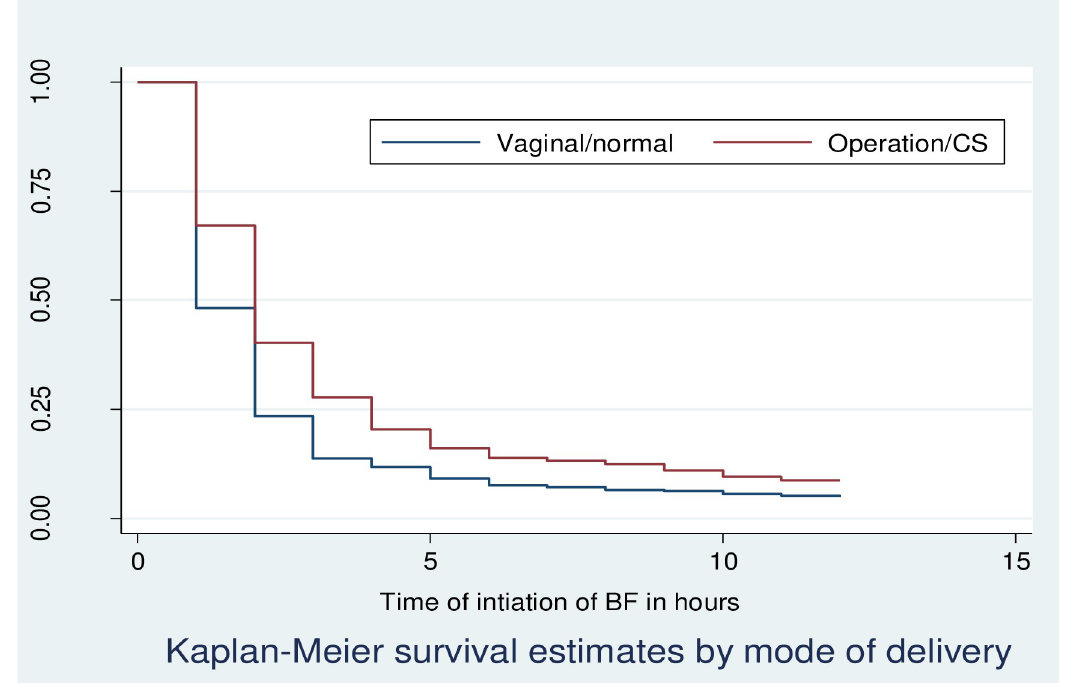
Fig 3. KM survival estimates by, mode of delivery among postnatal mothers within 12 hours of giving birth in Debre Markos Comprehensive Specialized Hospital, North West, Ethiopia, 2020.